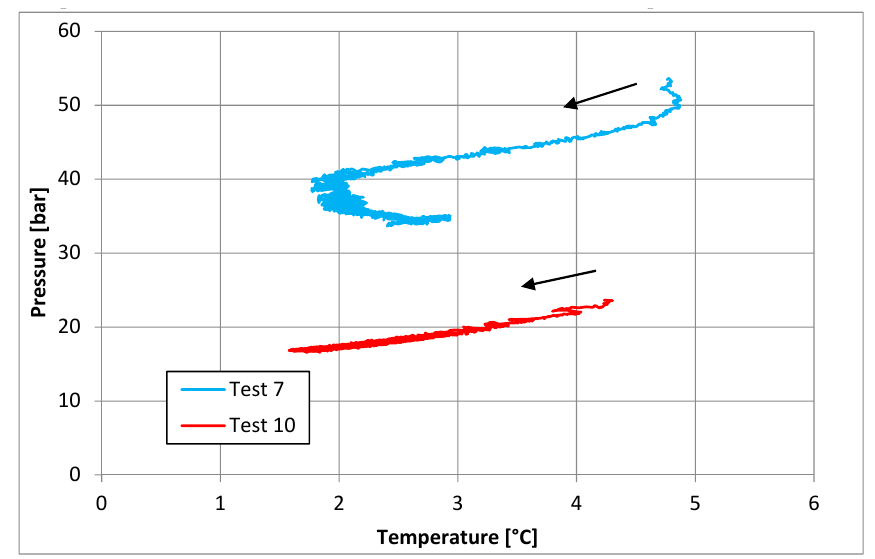
Figure 7. Comparison between Test 7, carried out using CH 4 , and Test 10, performed with CO 2 .